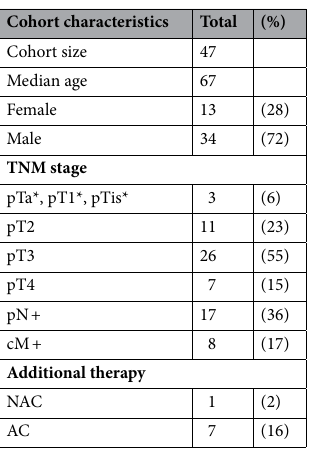
Table 2. Clinicopathologic characteristics of the Mannheim cohort. AC adjuvant chemotherapy, NAC neoadjuvant chemotherapy. *Muscle-invasive at TUR.